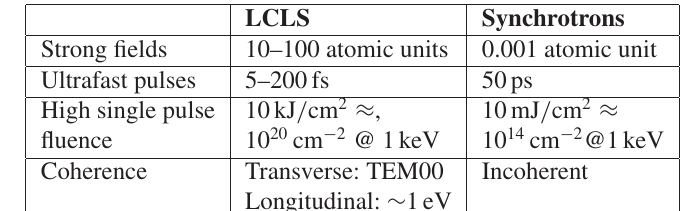
Table 1. LCLS properties vs. synchrotron x-ray